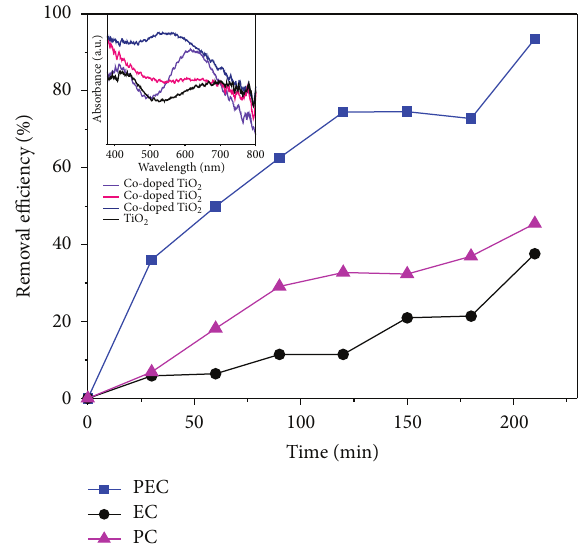
Figure9:Photocatalysis,electrolysis,andphotoelectrolysisremoval efficiency of humic acid on 2 :3 Cu/N codoped TiO 2